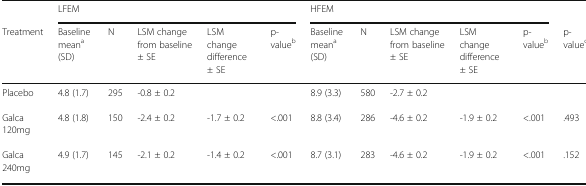
O19 Efficacy of galcanezumab in patients who failed prior preventive treatments for migraine: results from EVOLVE-1, EVOLVE-2 and